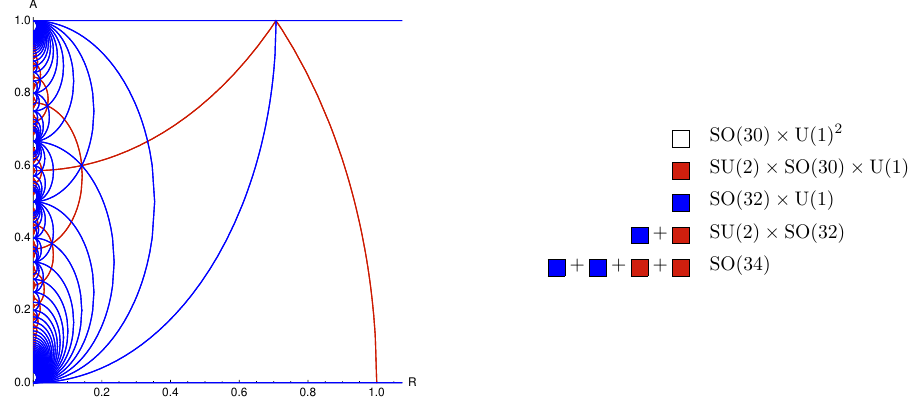
Figure 8. SO(32) heterotic with Wilson line A I = ( A; 0 15